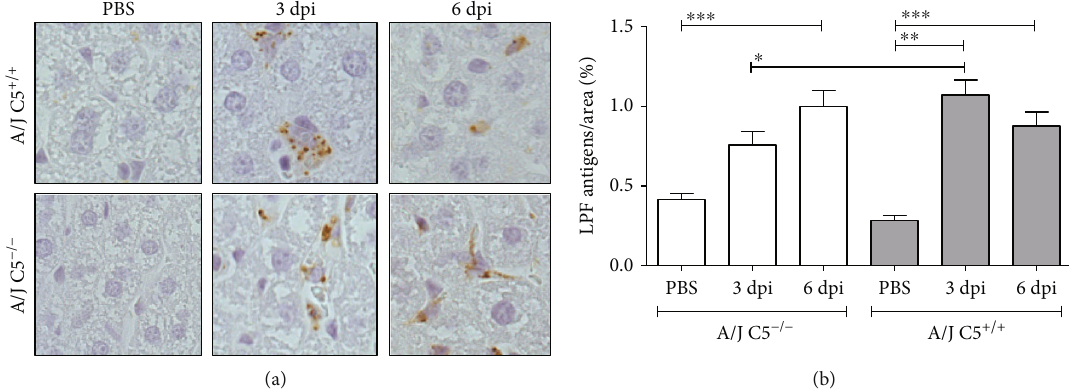
Figure 3: Presence of LPF antigens in the liver of LPF-infected A/J mice. (a) Liver sections from A/J mice were incubated with rabbit antileptospire immune serum. (b) Semiquantitative measurements of LPF antigens in the liver of infected A/J mice were performed in seven random fi elds of each section. Signi fi cant di ff erences are indicated as ∗ when p < 0 : 05 , ∗∗ p < 0 : 01 , and ∗∗∗ p < 0 : 001 . A/J -/- : C5- de fi cient mice, PBS ( n = 5 ), 3dpi ( n = 12 ), 6dpi ( n = 9 ); A/J C5 +/+ : congenic C5-su ffi cient mice PBS ( n = 4 ), 3dpi ( n = 10 ), 6dpi ( n = 9 ). dpi: days